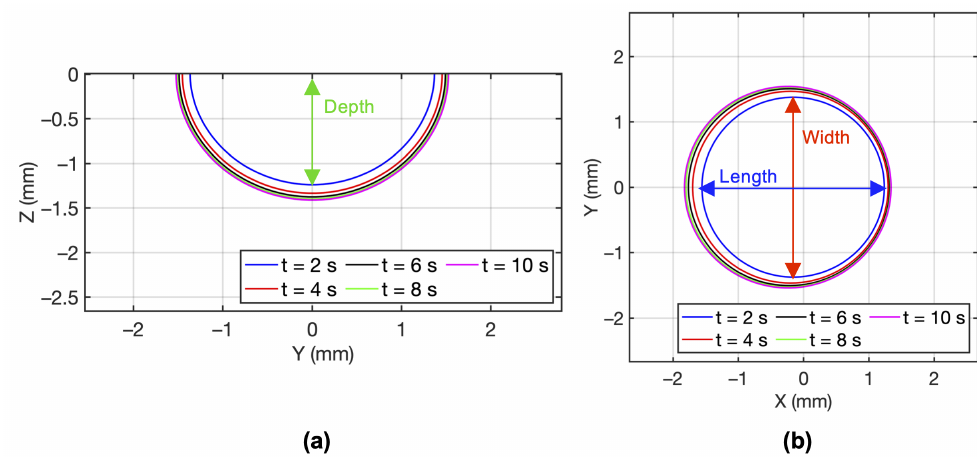
Figure 4. Temporal variation of the ( a ) melt pool depth and ( b ) melt pool length and width, for P = 1000 W and v = 1 mm/s. Table 1. Melt pool dimensions calculated using Eagar-Tsai for P = 1000 W and v = 1 mm/s. Melt Pool Melt Pool Melt Pool Time (s) Depth (mm) Width (mm) Length